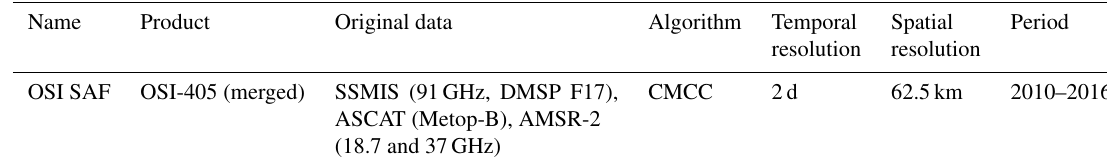
Table 1. OSI SAF drift data used in this study for comparison.